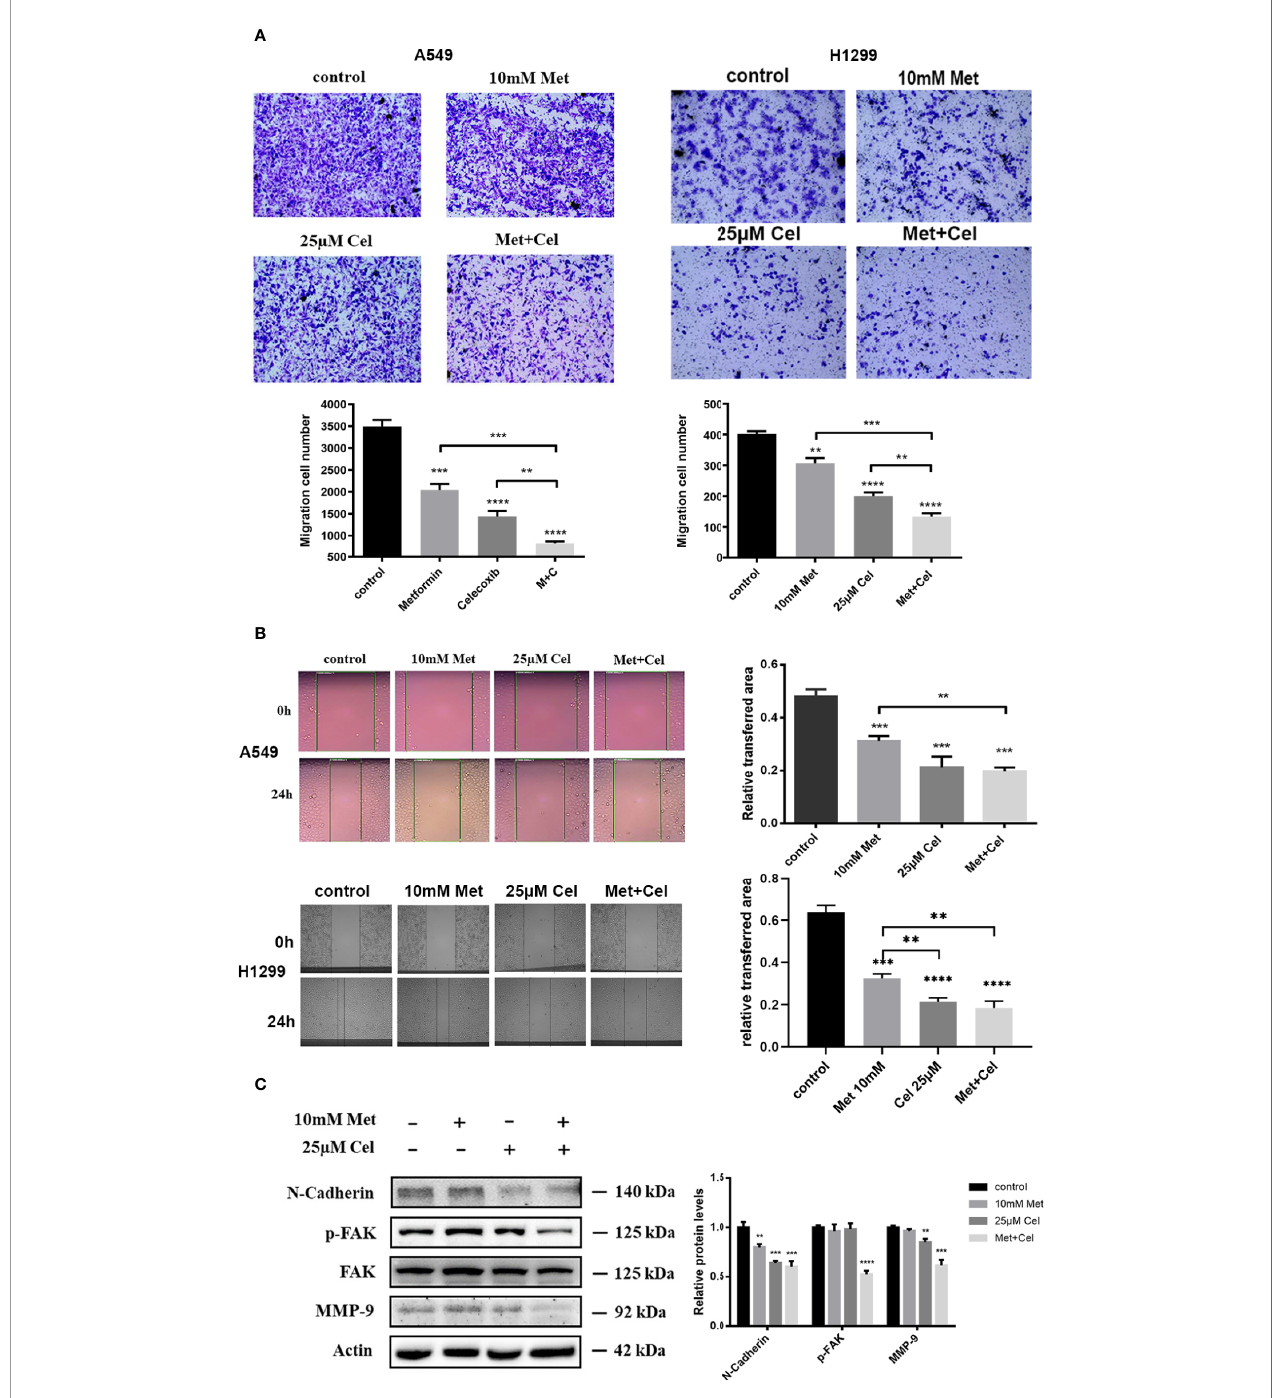
FIGURE 7 | Effect of celecoxib and metformin in combination on NSCLC cell migration. (A) Transwell assay. A549 and H1299 cells were treated with 10 mM metformin and/or 25 m M celecoxib. After 12 h pretreatment and 12 h incubation in the upper chamber, the cells migrating to the lower membrane were stained and counted in fi ve fi elds with a magni fi cation of × 100. The experiments were carried out in triplicate and representative data are shown. (B) Wound healing assay. A549 and H1299 cells were treated with 10 mM metformin and/or 25 m M celecoxib. Photographs were taken immediately and after 24 h of creating the scratch. Images shown are representative of three independent experiments. (C) Effects of metformin and celecoxib on N-Cadherin, FAK, p-FAK, and MMP-9 protein expression. A549 cells were treated with 10 mM metformin and/or 25 m M celecoxib for 48 h, and then harvested for Western blotting analysis using indicated antibodies. The level of actin served as the loading control. Band intensities were calculated using software Image J. Relative intensities are also shown. Data represent mean values of triplicate samples. Data are represented as mean ± SD. * p < 0.05, ** p < 0.01, *** p < 0.001, **** p <